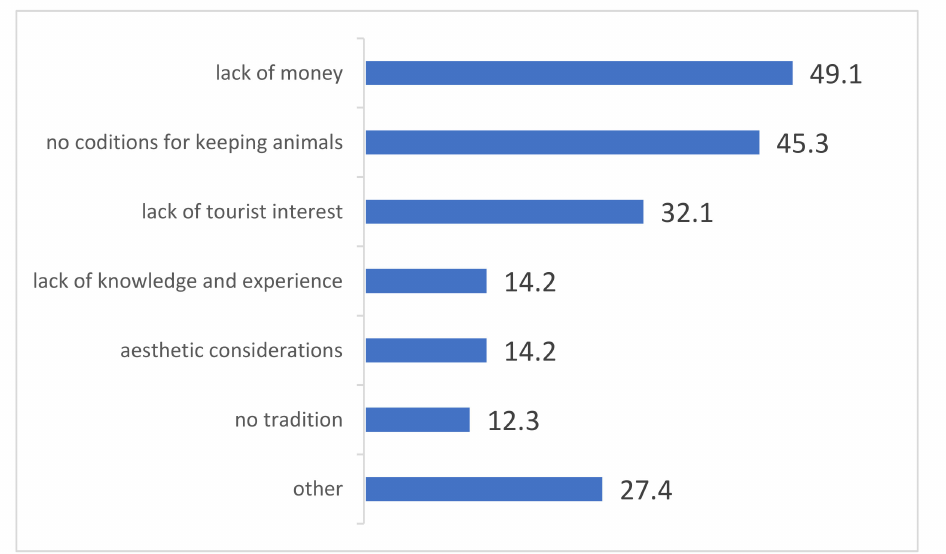
Figure 1. Reasons for not keeping livestock. Source: own